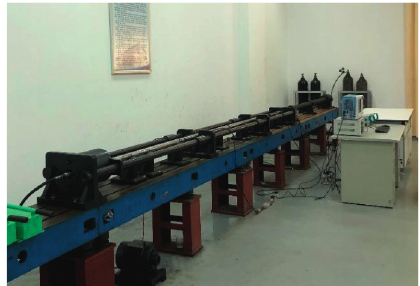
Figure 2: Split Hopkinson pressure bar test